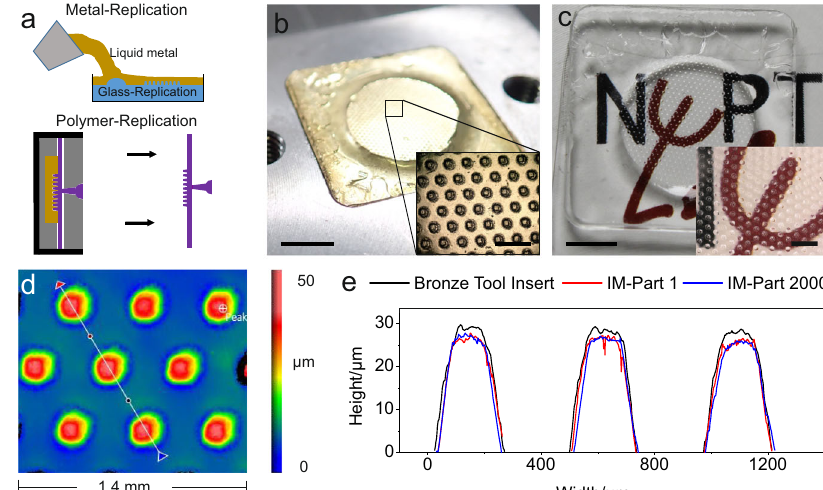
Fig. 3 | Polymer injection moulding using casted metal moulds. a Schematic representation of the manufacturing process of a metal insert and its use in injection moulding. b Close-up of the injection mould which was used as an insert (scale bar: 10mm). The inset shows a magni fi cation of the dot matrix struc- ture (scale bar: 500 µ m). c Close-up of an injection-moulded poly- methylmethacrylate (PMMA) component replicated from the metal insert